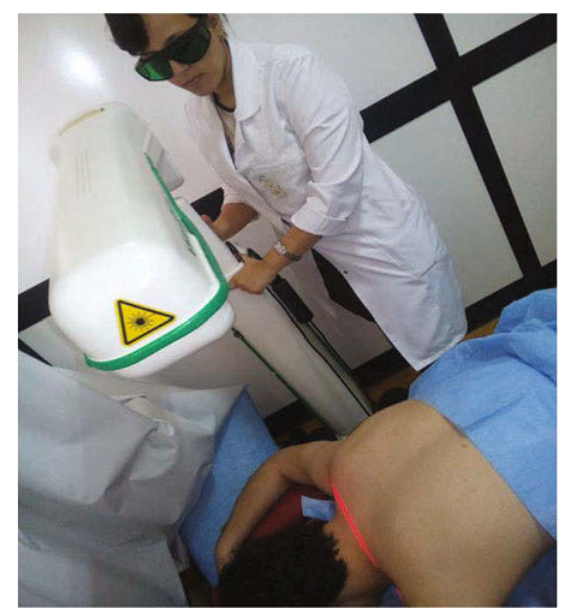
Laser application to the cervical